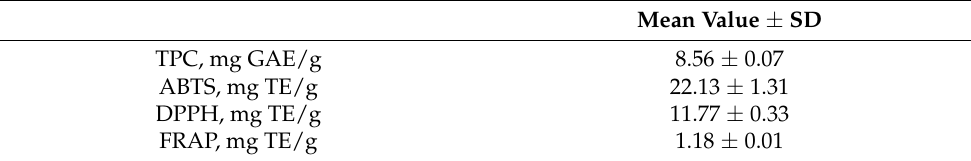
TPC, total phenolic content; GAE, gallic acid equivalents; ABTS, 2,2 (cid:48) -azino-bis(3-ethylbenzothiazoline-6-sulfonic acid) diammonium salt; DPPH, 2,2-diphenyl-1-picrylhydrazyl; FRAP, ferric reducing antioxidant